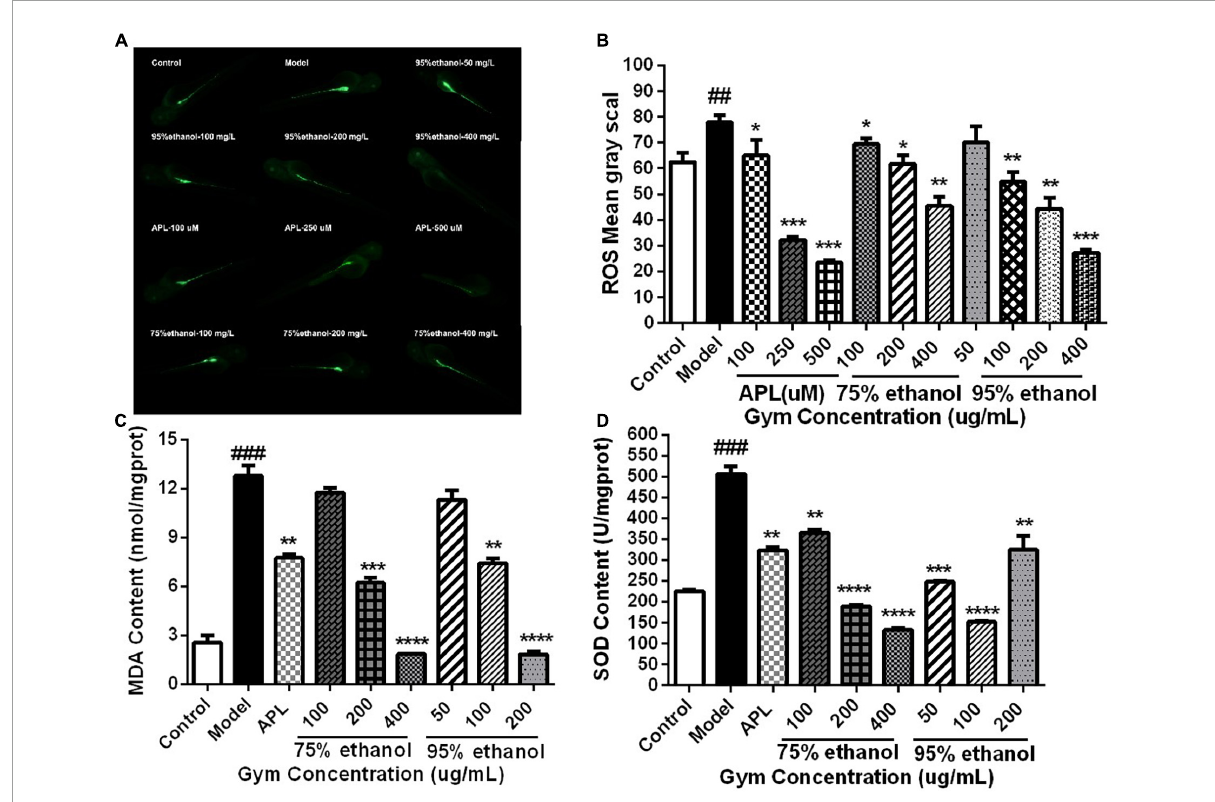
FIGURE8 The effects of ethanolic extracts of Gym on oxidative stress-related indexes of HUA zebrafish. (A) Fluorescence diagram of ROS of ethanolic extract of Gym. (B) Grayscale diagram of ROS content of ethanol extracts of Gym. (C) The effect of ethanolic extracts of Gym on MDA content. (D) The effects of ethanolic extracts of Gym on SOD content. * P < 0.05, ** P < 0.01, *** P < 0.001. # P < 0.05, ## P < 0.01, ### P <